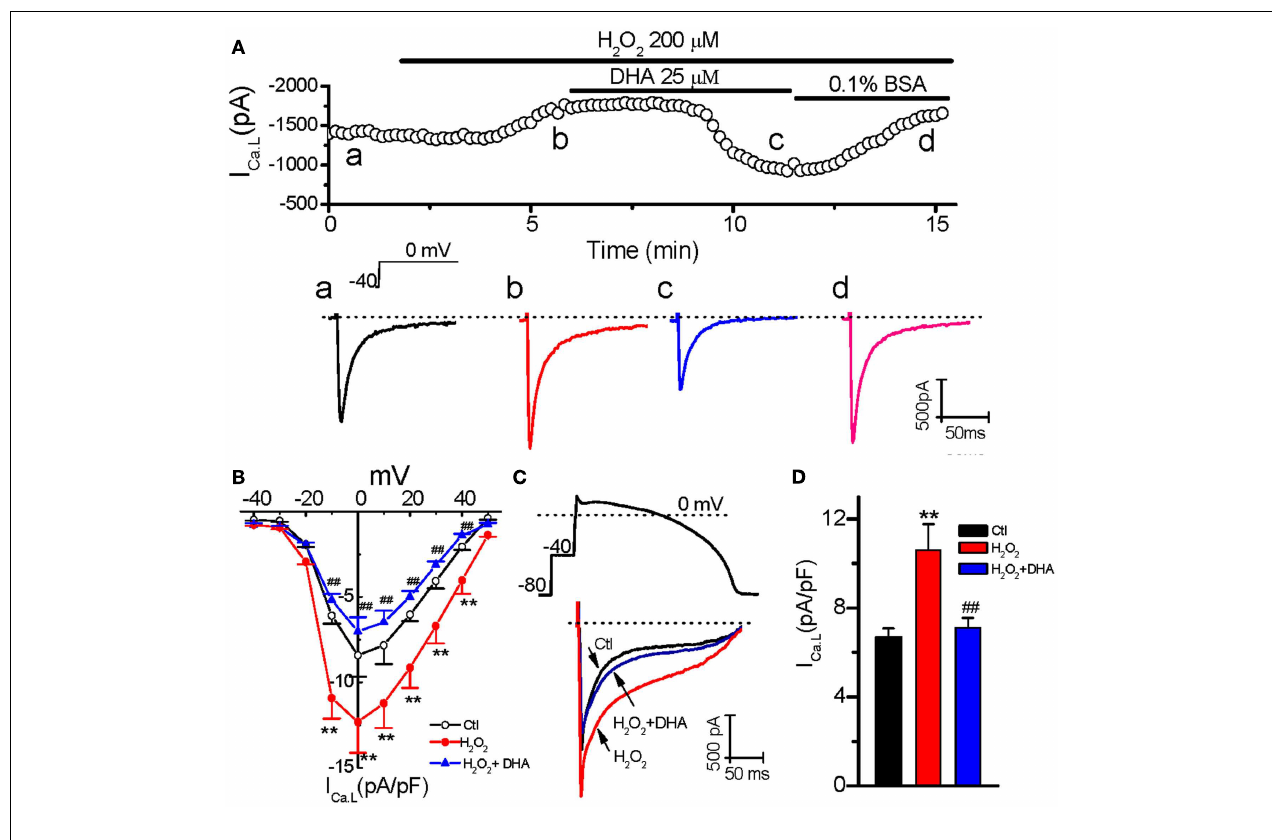
steps. (C) An AP-clamp waveform (above) and superimposed current traces showing I Ca,L under control (Ctl), in the presence of 200 µ M H 2 O 2 , and DHA(25 µ M) + H 2 O 2 are shown respectively. (D) The late phase currents measured at 30-150ms after the upstroke in (C) were summarized showing an inhibitory effect of DHA on the enhancement of I Ca,L by H 2 O 2 ( n = 6). ** p < 0.01 vs. control; ## p < 0.01 vs. H 2 O 2